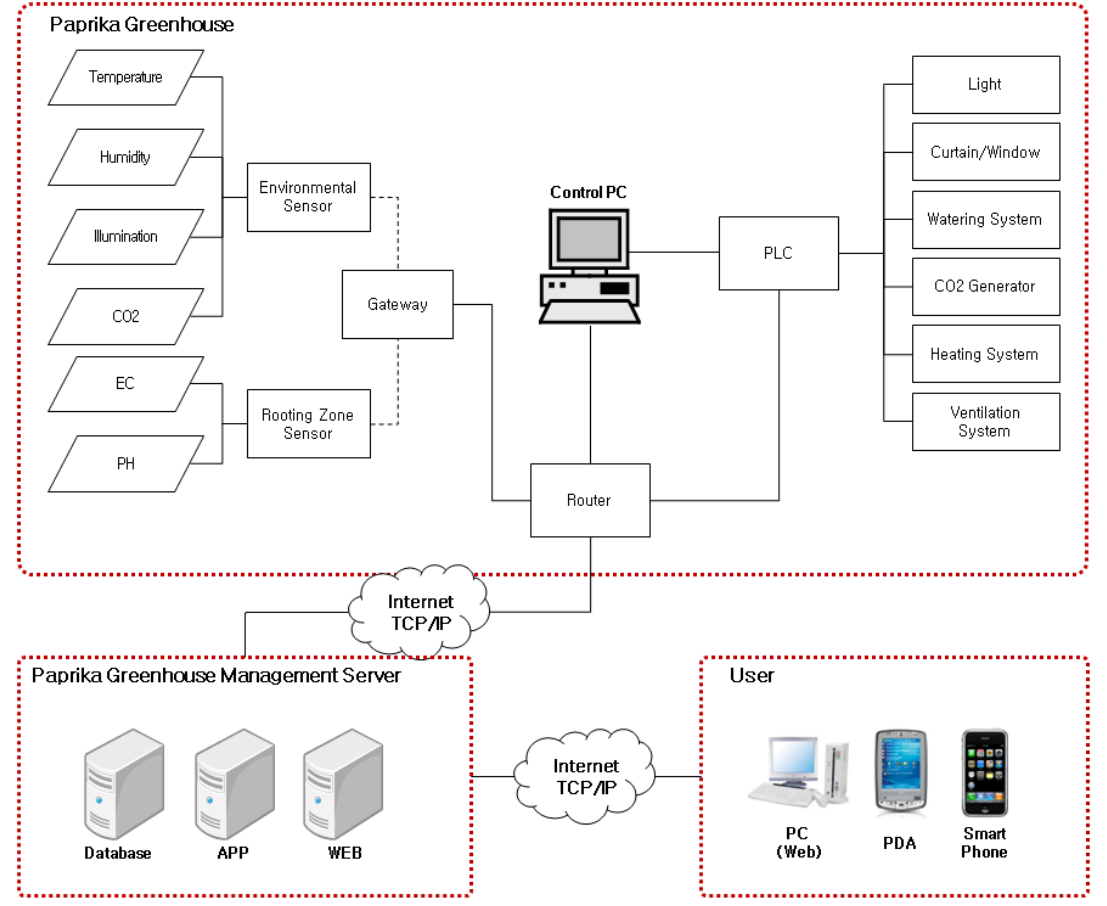
Figure 8. Block Diagram of Proposed Ubiquitous Paprika Growth Management